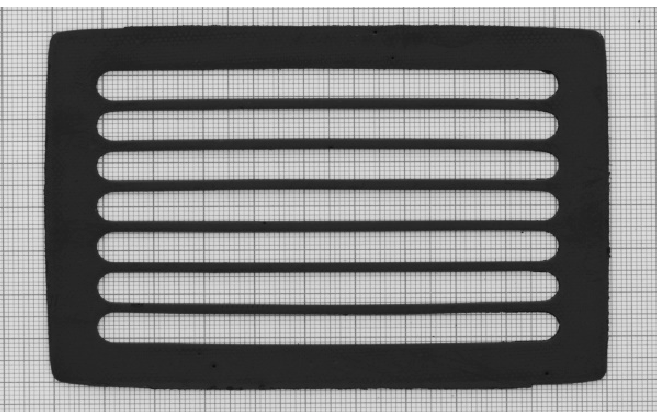
Figure 3. Green interlayer sample (80 mm × 110 mm) after punching out of the flow channels. A half-component is obtained by laminating a punched interlayer with an asymmetric membrane having the same dimension. The two layers, after being stacked one on top